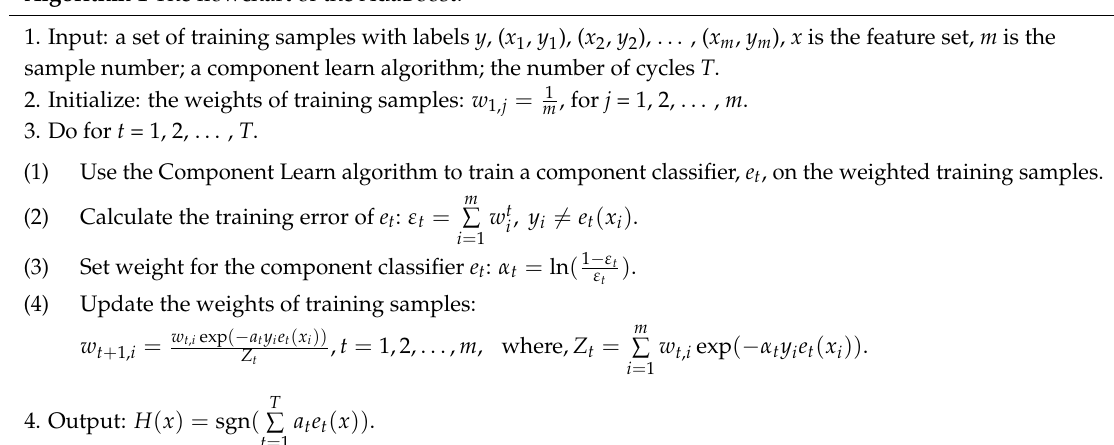
Algorithm 1 The flowchart of the AdaBoost.